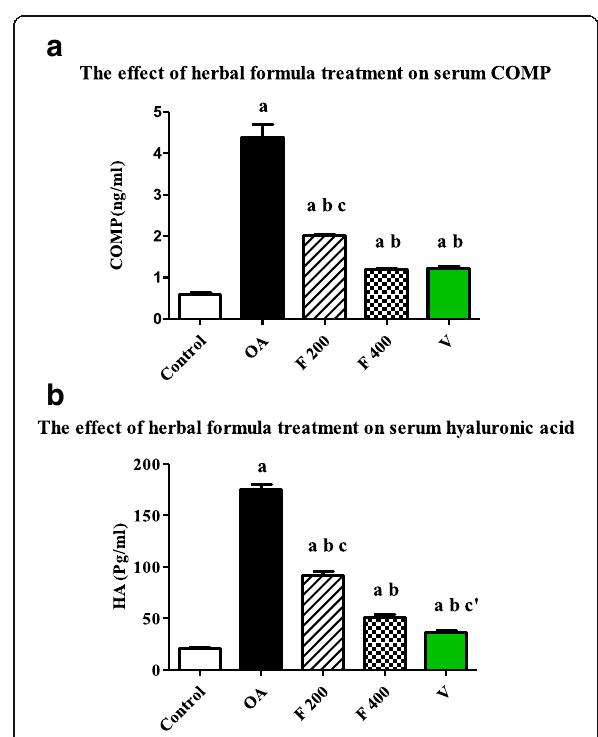
Fig. 1 a Serum level of COMP (ng/ml) in the experimental groups. Herbal formula treatment decreased serum level of COMP in the osteoarthritic rats at the end of 1 month treatment; C=control; OA=osteoarthritis; F 200=herbal formula 200 mg/kg; F 400=herbal